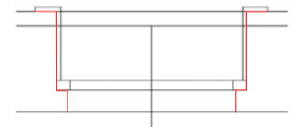
Figure 9. Selection of detectable window styles.